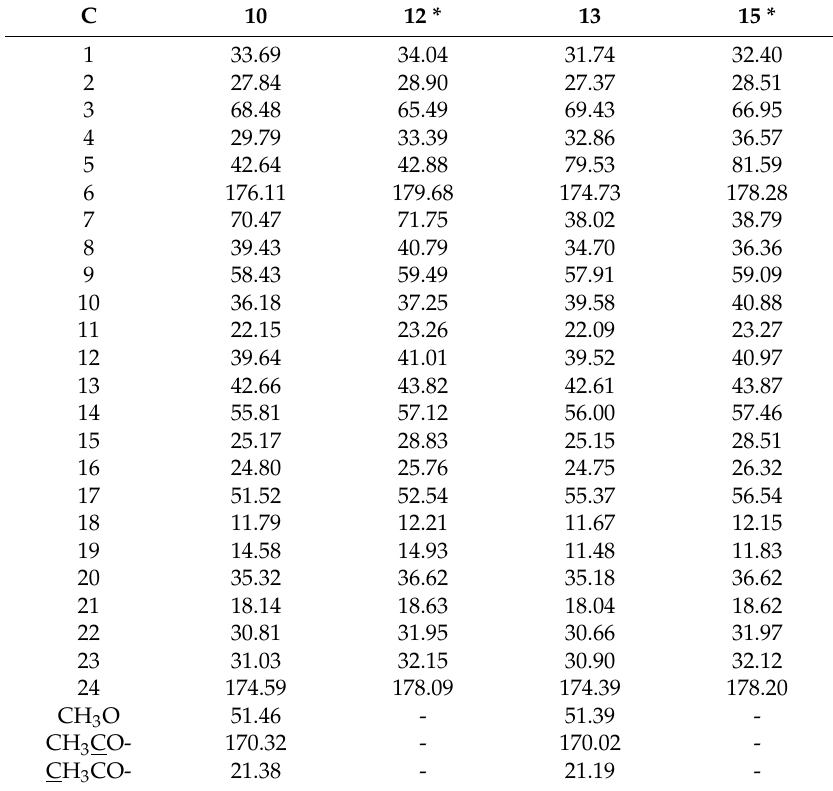
Table 1. δ 13 C-RMN (CDCl 3 , 100.6 MHz) for compounds 10 , 12 , 13 and 15